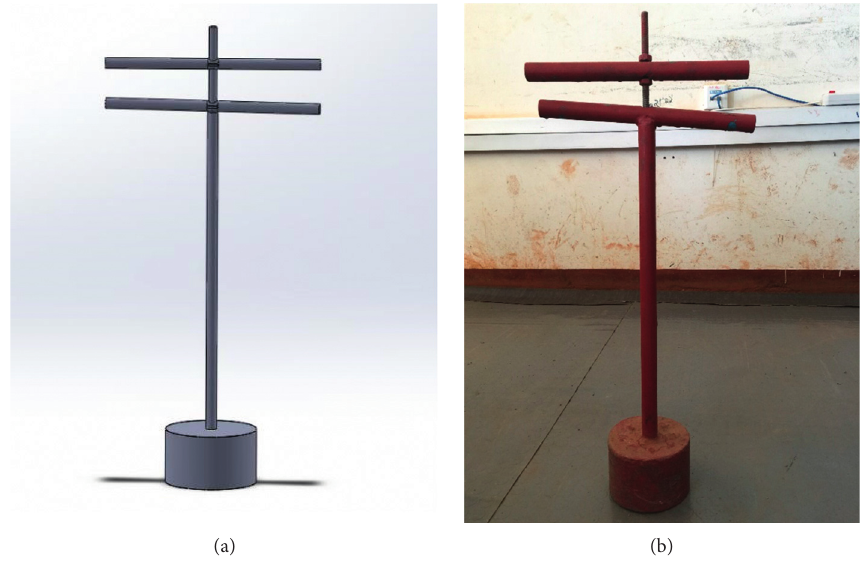
Figure 1: (a, b) Manually operated briquette molder.